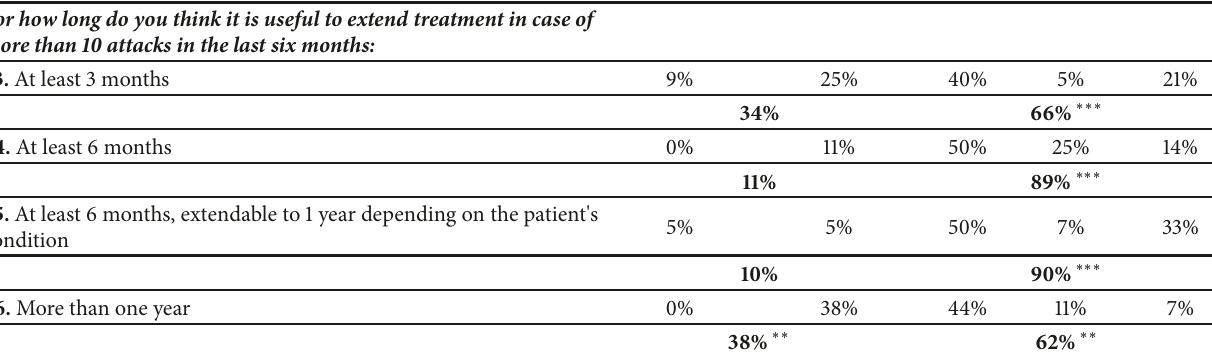
Table 5: Results of the Consensus Conferenceon betahistinetreatmentduration. 1 = absolutelydisagree, 2 = disagree, 3= agree,4 = more